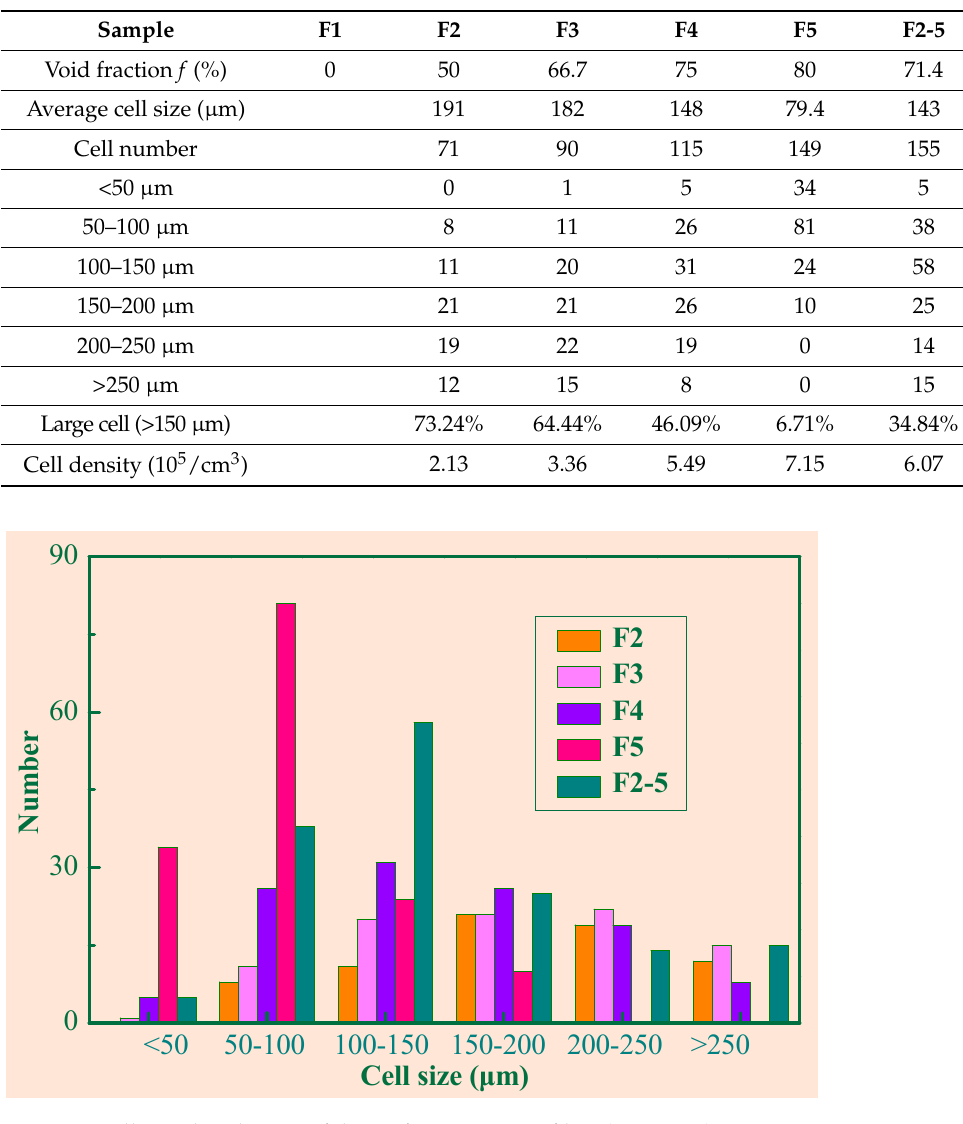
Figure 4. Cell size distribution of the SR/Gr composite films (1 wt% Gr).